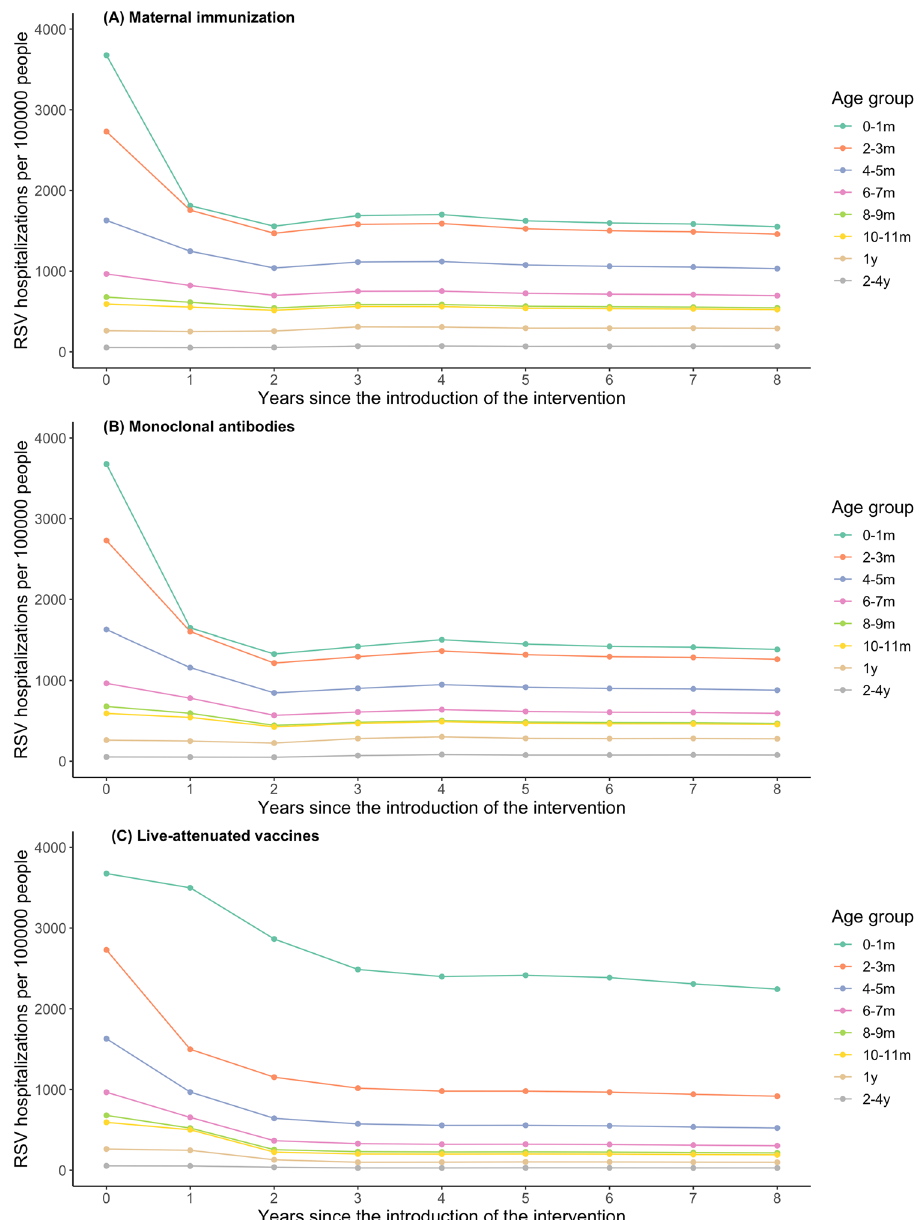
Fig. 1 RSV hospitalizations per 100,000 people across age groups before and after the introduction of three RSV prevention strategies. Annual RSV hospitalizations per 100,000 people over time and across age groups are presented for A maternal immunization, B extended half- life monoclonal antibodies, and C live-attenuated vaccines. Year 0 corresponds to the RSV hospitalization incidence before the introduction of RSV prevention strategies. The predicted RSV hospitalization incidence over time is plotted for Years 1 to 8 after the introduction of the intervention. We assumed 85 – 95% coverage for all three interventions. The color of the lines corresponds to each age group as indicated by the